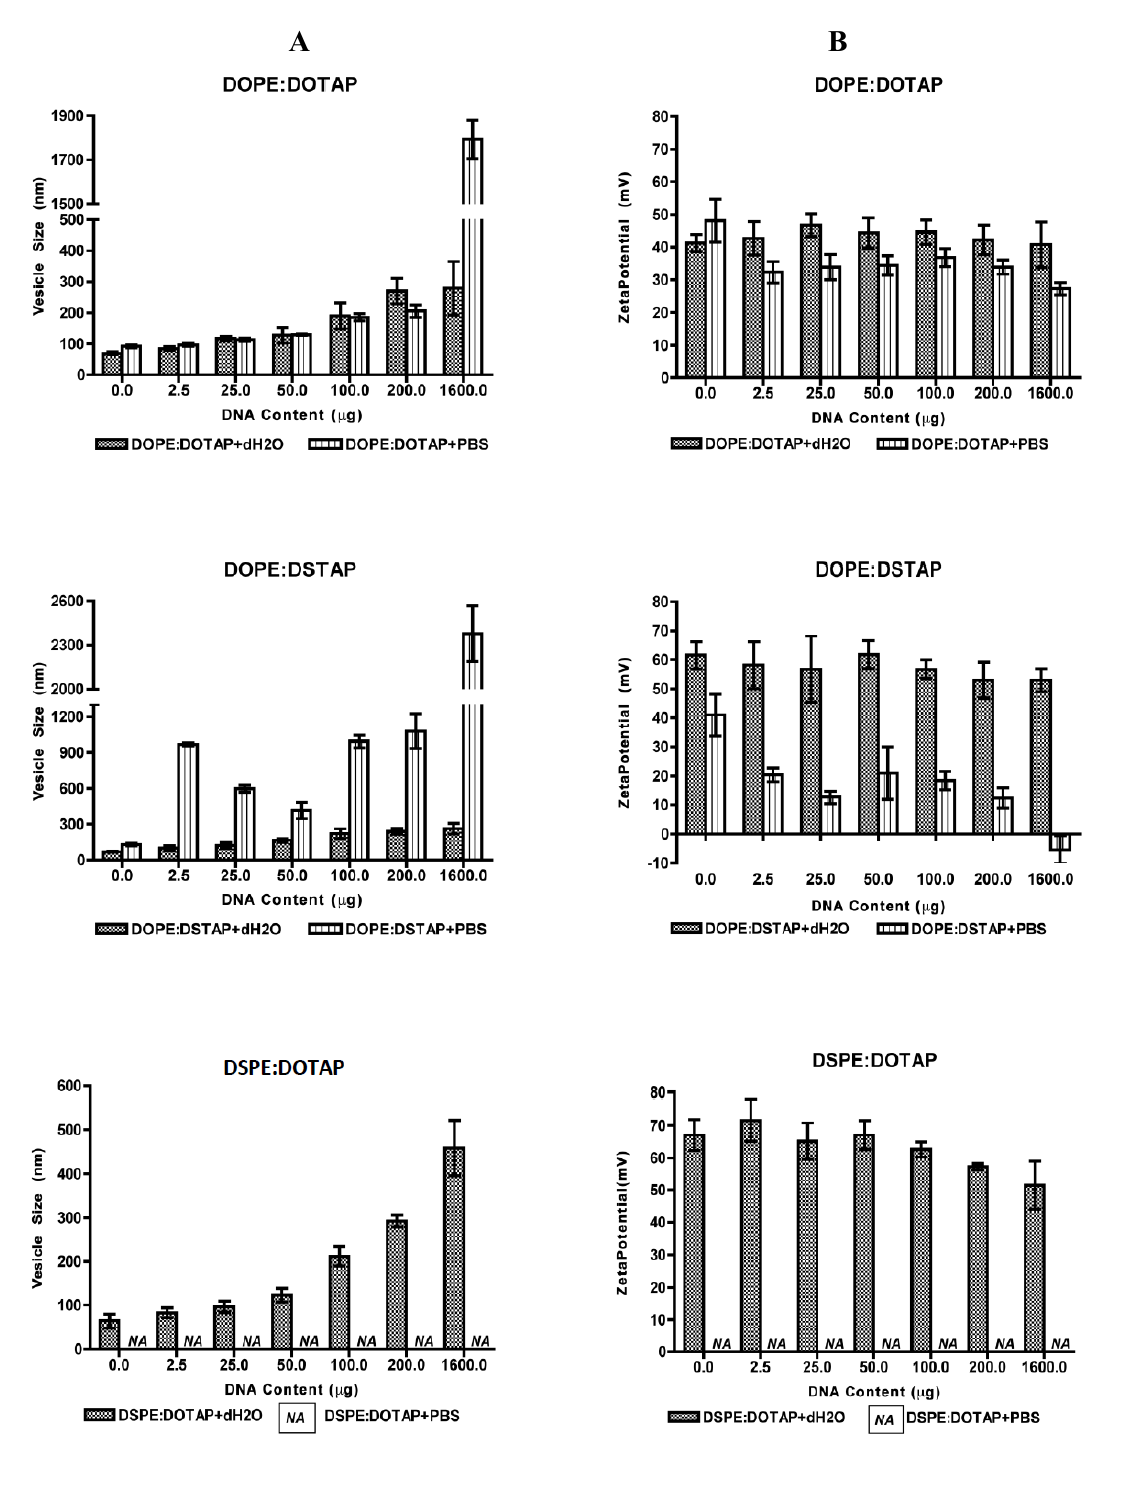
Figure 4. Vesicle size ( A ) and Zeta potential ( B ) of DNA lipoplexes of DOPE:DOTAP, DOPE:DSTAP, DSPE:DOTAP in distilled water and PBS and in various concentrations of DNA. Results denote mean ± SD, n =